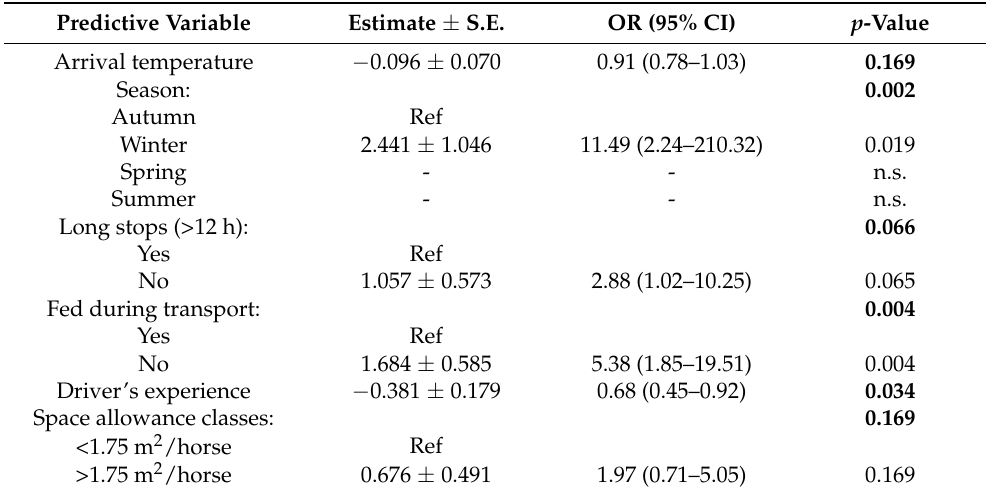
Table 14. Significant associations between the predictive variables and the presence/absence of nasal discharge 24 h after unloading. Data are presented as estimate, standard error (S.E.), odds ratio (OR), confidence interval (95% CI), and p -value.